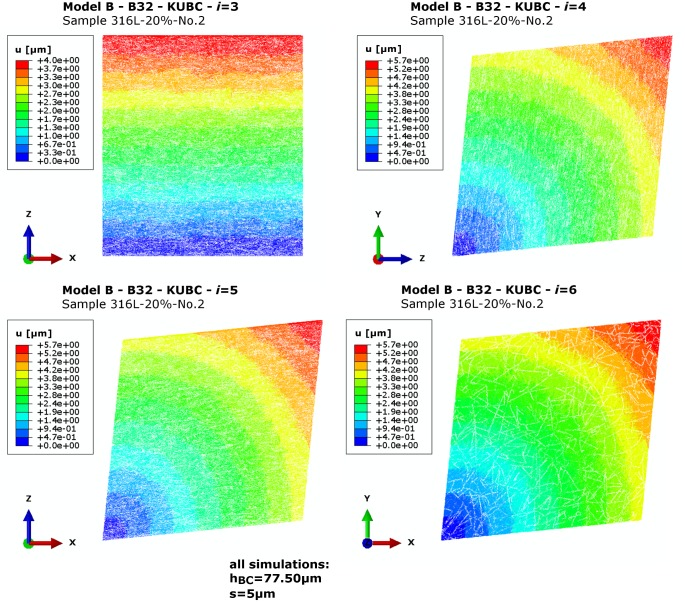
Model B—Deformation plot.Obtained u [μm] for sample 316L-20%-No.2 in load cases i = 3 to 6.